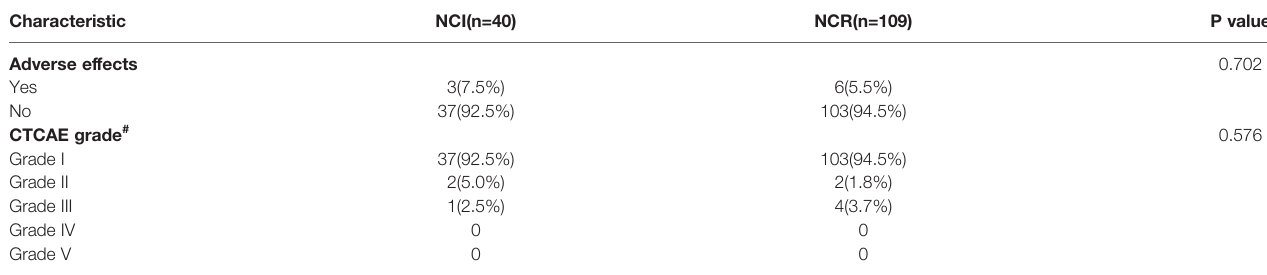
TABLE 3 | The adverse effects of neoadjuvant treatments.